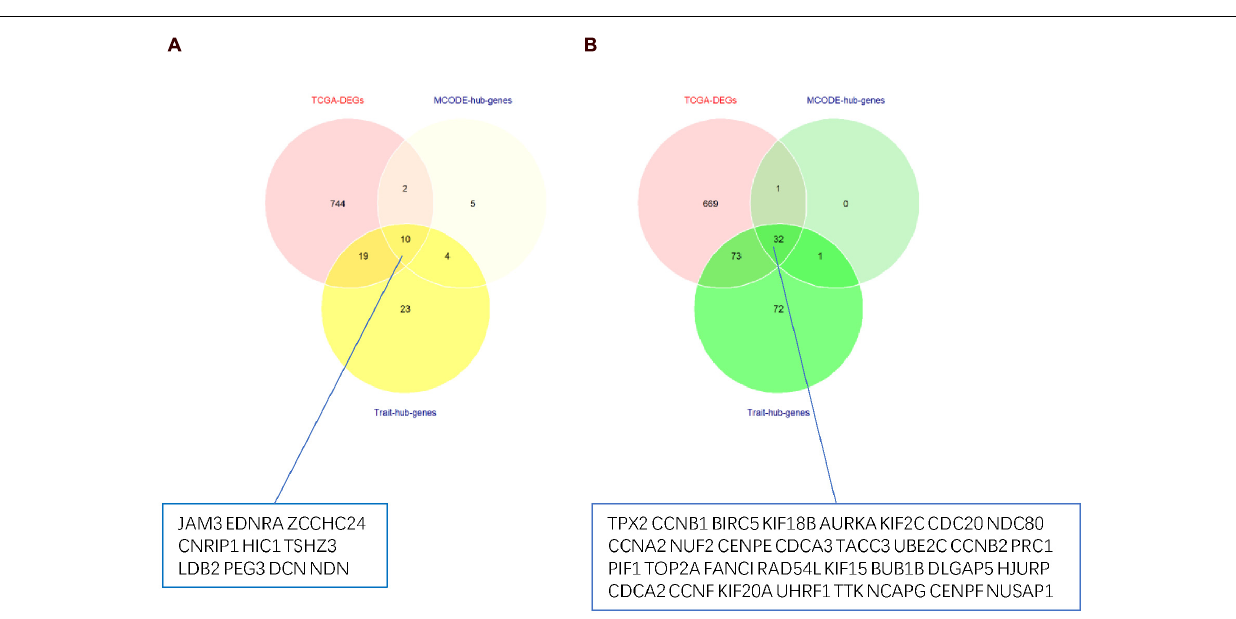
The AUCs with respect to the ROCs for 2-, 3-, and 5-year OS were 0.683, 0.703, and 0.684, respectively ( Figure 9B ). The distributions of the risk scores, survival status, and survival duration of the 543 EC patients and the expression heatmap for